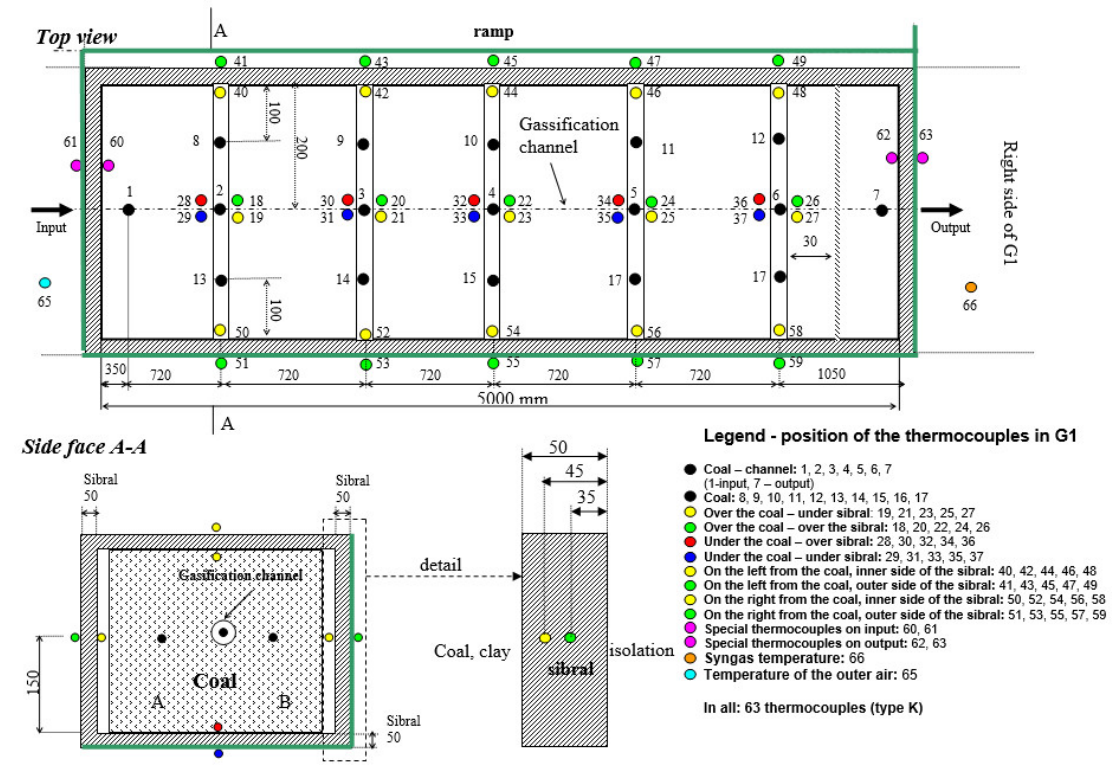
Figure 4. The scheme of the position of the thermocouples in the reactor for the first experiment.